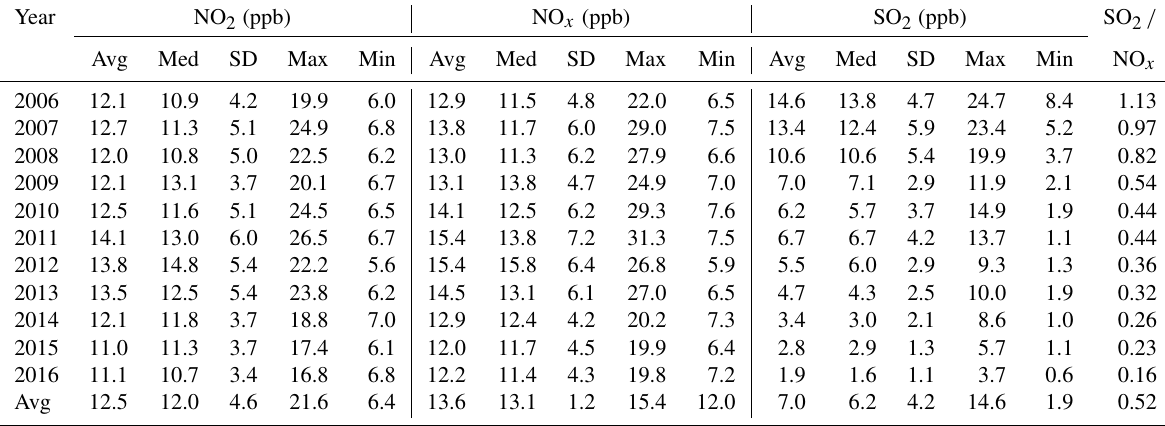
Table 1. Statistics of NO x and SO 2 levels from 2006 to 2016 at LAN.